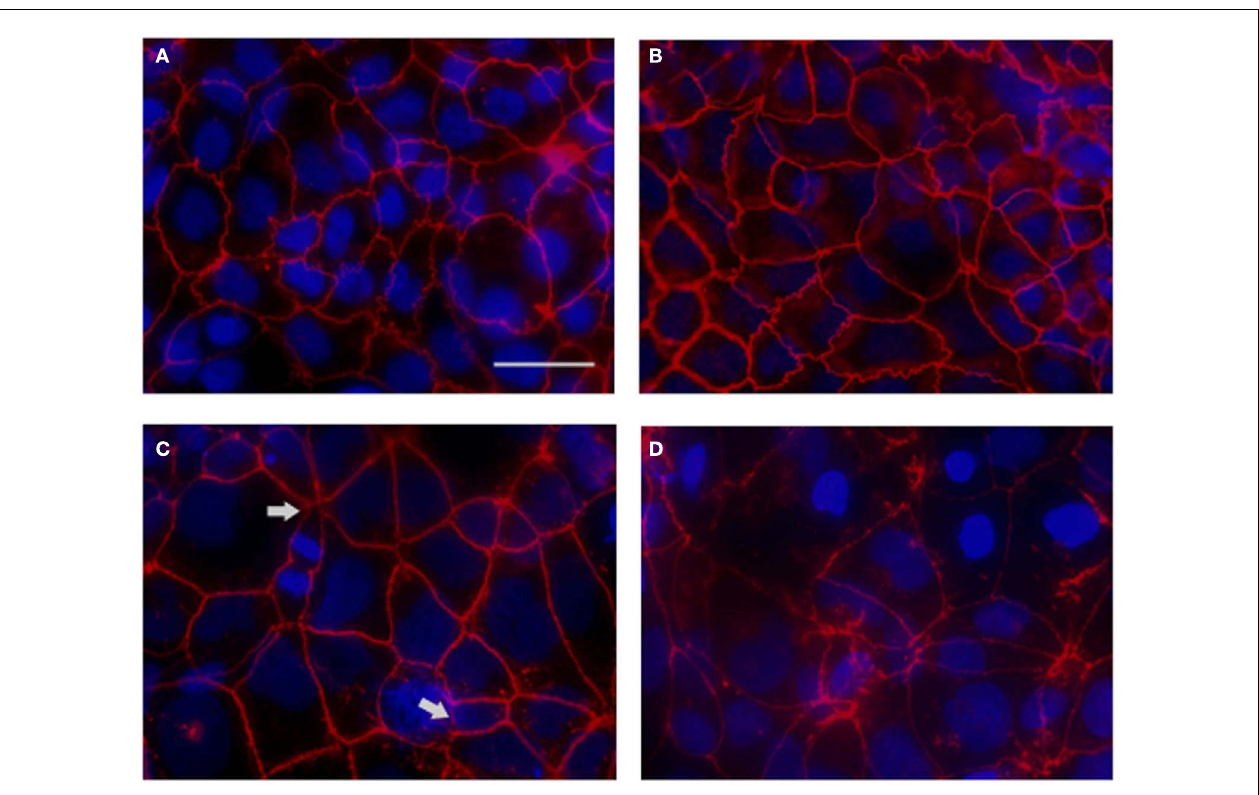
FIGURE 7 | ZO-1 staining of S .Typhi and mutant strains infected monolayers at 22h post-infection. (A) Uninfected control. (B) CVD 909. (C) Ty21a. (D) Wild-type S .Typhi. ZO-1 staining (red), DAPI for the nuclei (blu). Areas of severe ZO-1 disruption are marked by arrows. Bar, 30 µ